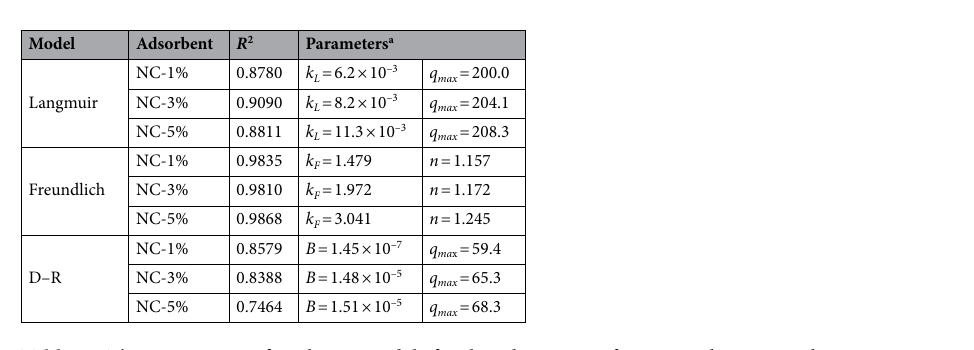
Table 3. The parameters of isotherm models for the adsorption of CR onto the prepared nanocomposites. a The units are mentioned in “Initial CR concentration and adsorption isotherm”section.